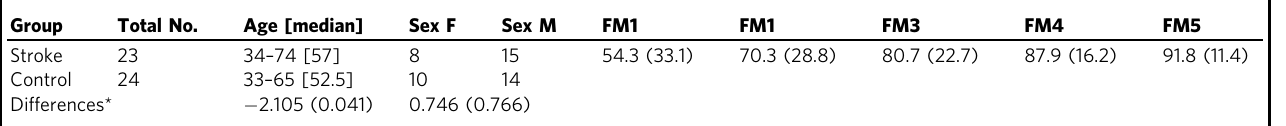
Table 1 Demographic and clinical characteristics of sample. Group Total